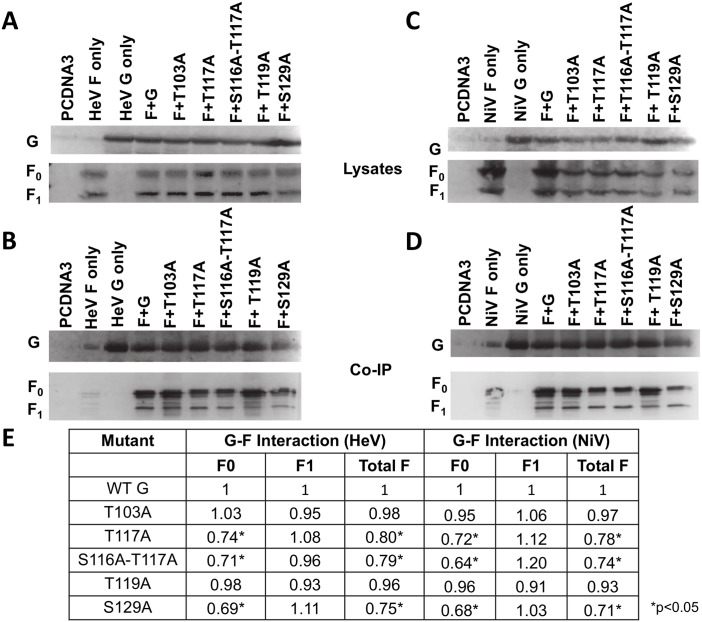
Associations with F are altered by O-glycan loss.A) Cell lysates of cells transfected with wt F and either wt or mutant HeV G. HeV G (top) is blotted with rabbit anti-HA, and HeV F (bottom) is blotted with mouse anti-AU1. B) Pulldown of HeV G and co-IP of F for transfected cells. Antibody blotting was performed as in A). C) Cell lysates of cells transfected with wt F and wt or mutant NiV G. D) Co-IP of NiV transfected cells. E) Co-IP values of HeV and NiV O-glycan mutants, determined by densitometry. Image Lab software (Biorad) was used to measure the densitometry of Western blot bands. Co-IP values were determined by dividing either the F0, F1, or total F densitometry values for the co-IP bands by the co-IP G densitometry values to account for any differences in co-IP G pulldown. These values were then divided by F0, F1, or total F densitometry values for cell lysates to account for differences in F mutant expression. Values were then normalized to those of wt HNV G. Averages are shown. N = 3. Statistically significant differences, as determined by a Student’s t-test, are marked with an * (p<0.05).